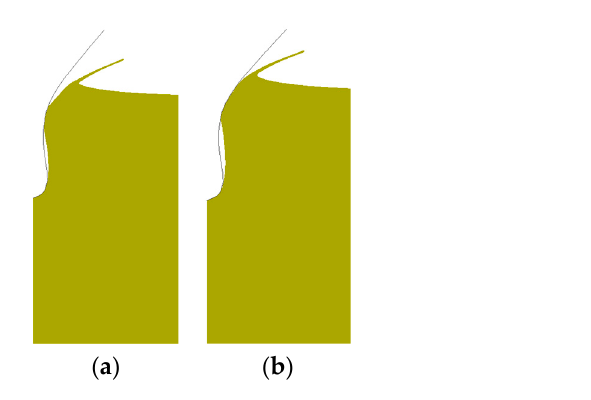
Figure 10. Flare slamming of the bow under two loading conditions: ( a ) Lightship weight; ( b ) full